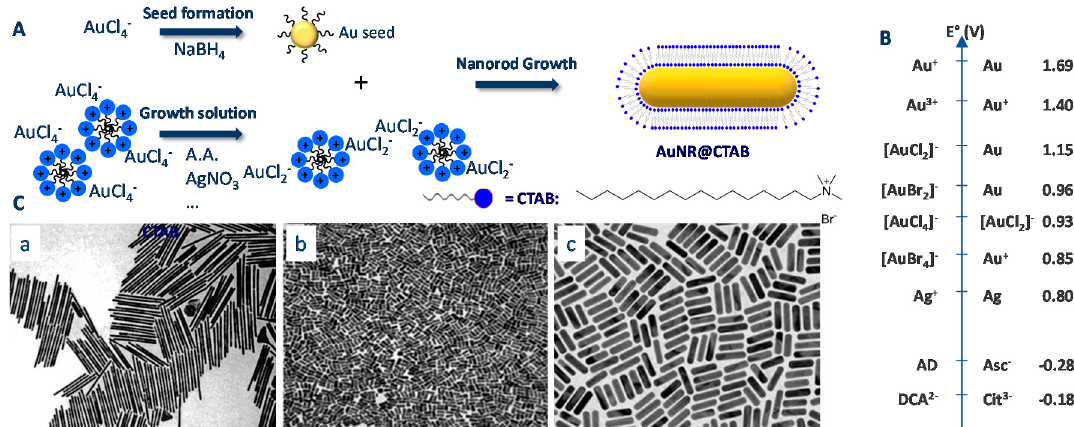
Figure 1. ( A ) Synthesis of gold nanorods (AuNRs) from crystal seed according to the seed-mediated growth method, and ( B ) standard potential in aqueous solution of different Red/Ox couples playing a role in the reaction of AuNR formation [32–34] and ( C ) TEM images of AuNRs synthesized following ( a ) Jana et al.’s method [28], ( b ) Sau et al.’s method [29], and ( c ) Ye et al.’s method [30].